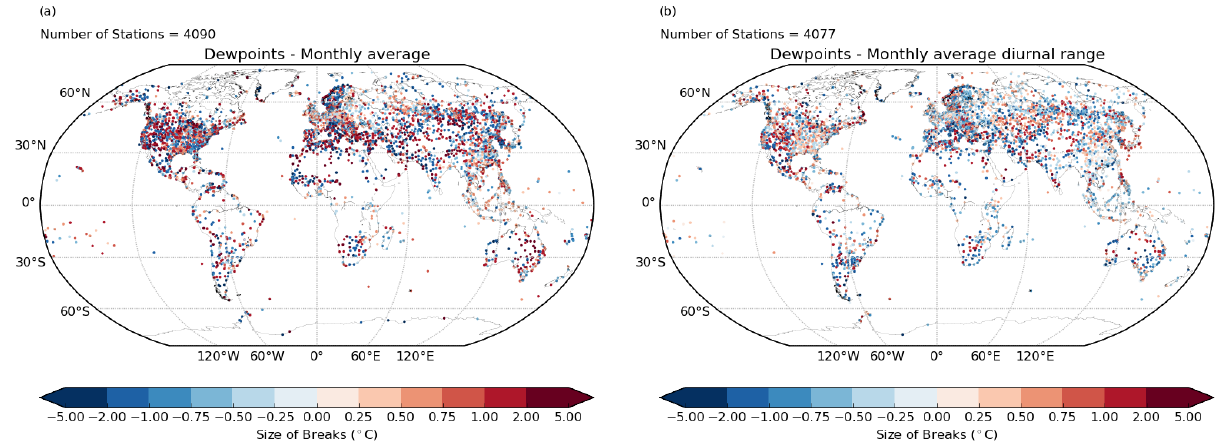
Figure 12. As for Fig. 6 but for (a) monthly averages of dew point temperatures and (b) monthly-average diurnal ranges of dew point Fig. 12. As for Fig. 6 but for (a) monthly averages of dewpoint temperatures and (b) monthly average diurnal ranges of dewpoint tempera- temperatures. tures.